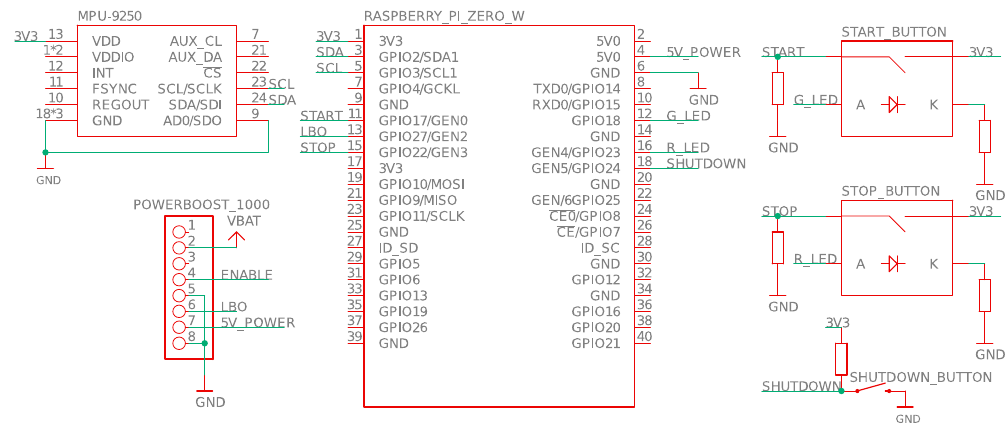
Figure 2. Schematics of the prototype device.